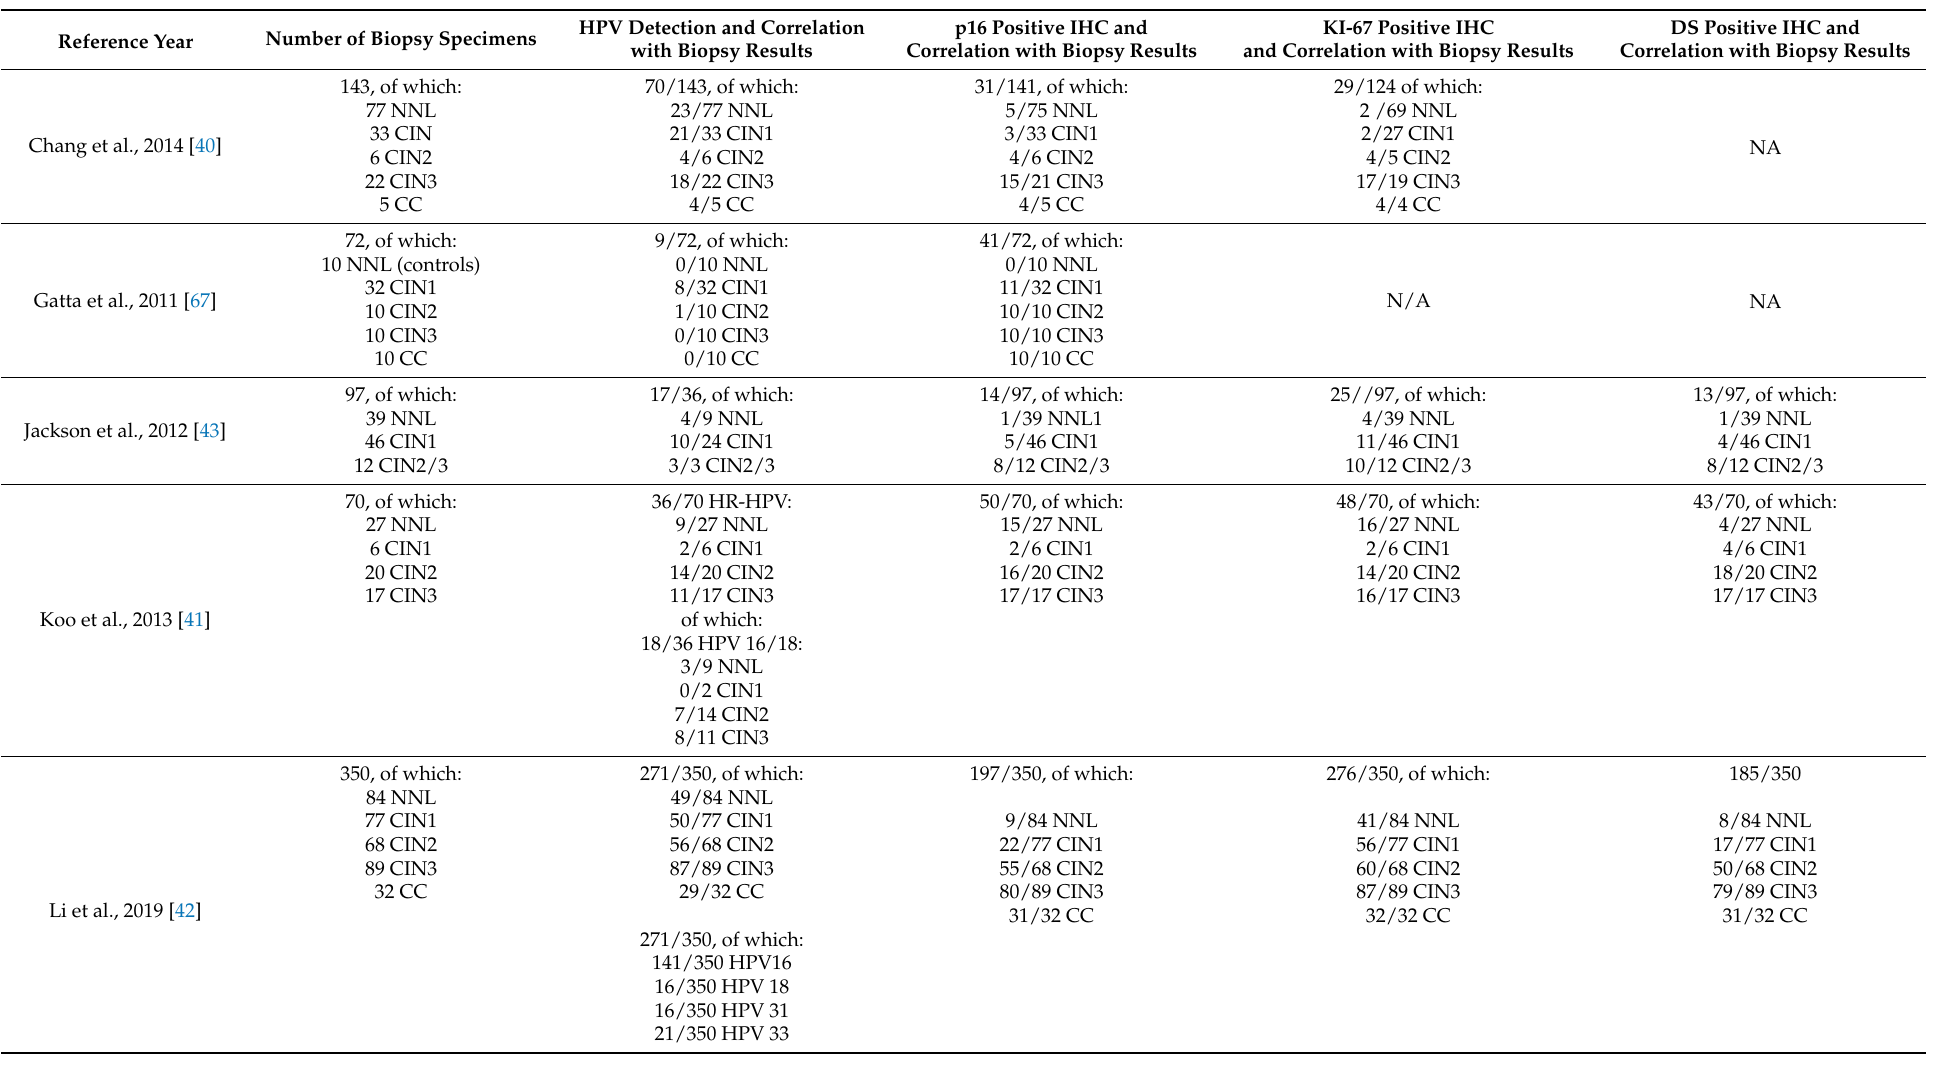
Table 3. p16, Ki-67 and DS IHC in cervical tissue biopsy